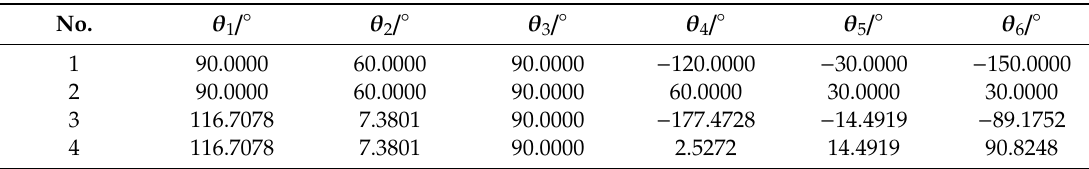
Table 11. Four inversely solved joint angle sets.